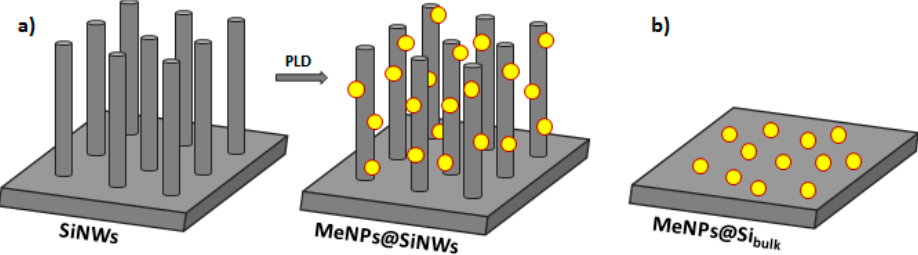
Figure 1. ( a ) Schematic of pulsed laser decoration of SiNWs (Me = Au or Cu) and ( b ) Metal NPs supported on bulk silicon.